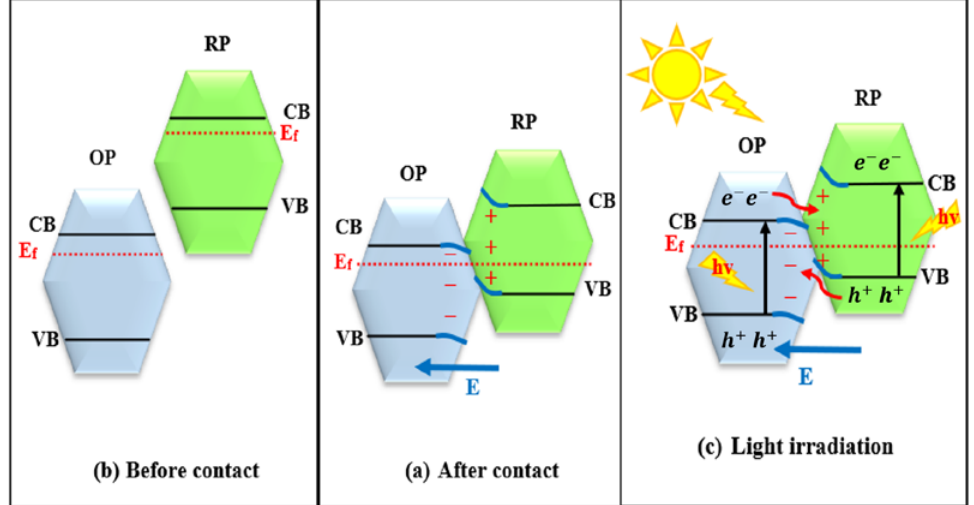
Figure 19. The charge-transfer processes leading to enhanced efficiency in an S-scheme heterojunction, before contact ( b ), after contact ( a ) and with light irradiation ( c ).